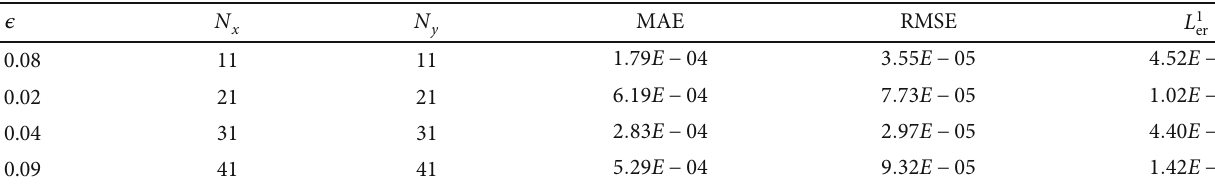
Table 2: Errors for example 4.1 for some values of N